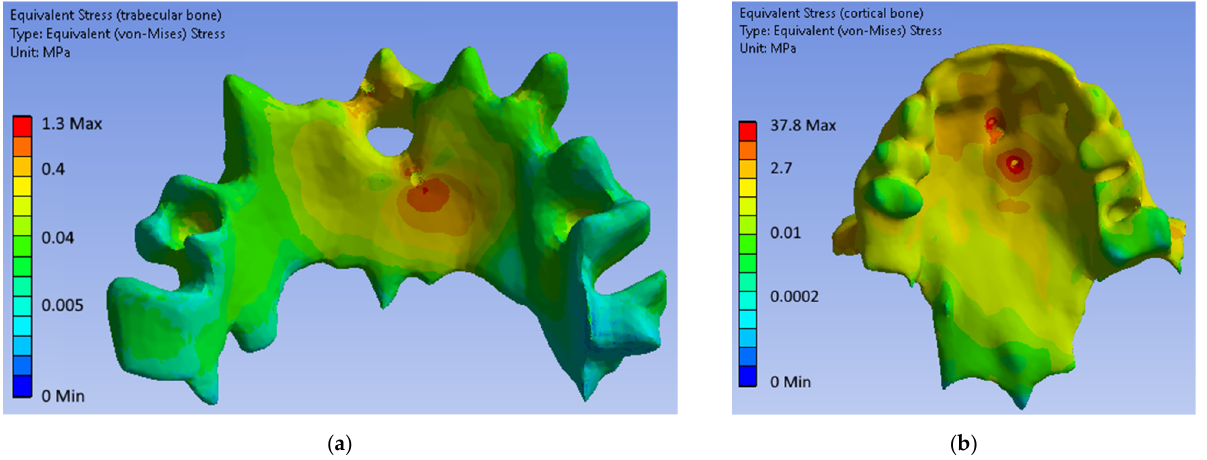
Figure 10. Equivalent stresses in bone tissues for the fourth configuration of mini-implants (Model 4): ( a ) trabecular bone; ( b ) cortical bone.